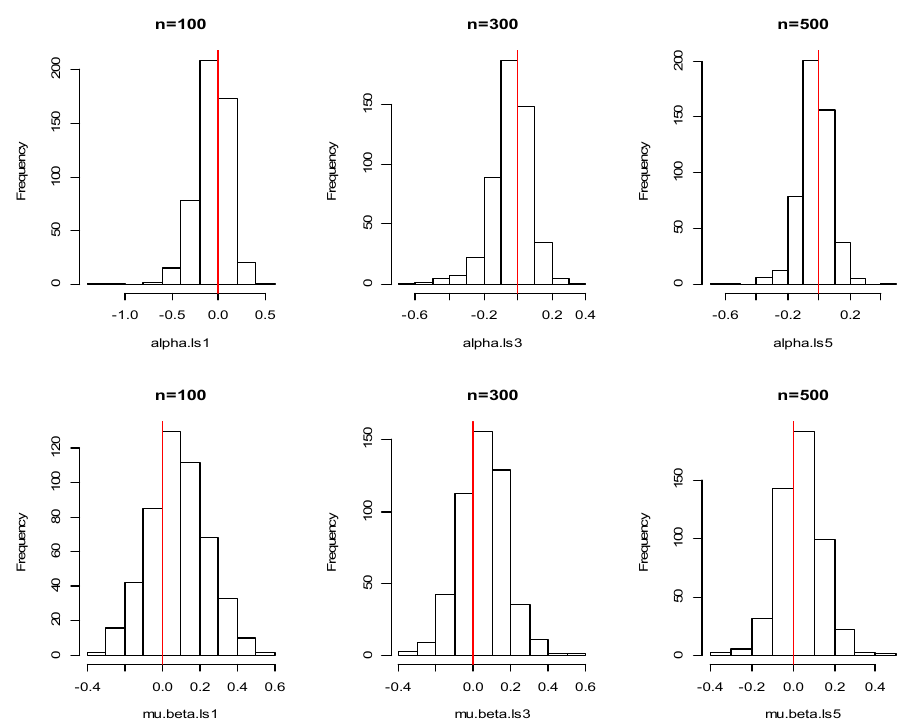
Figure 4. Histogram of estimated parameter α and µ β with the least-squares method in Case 1.